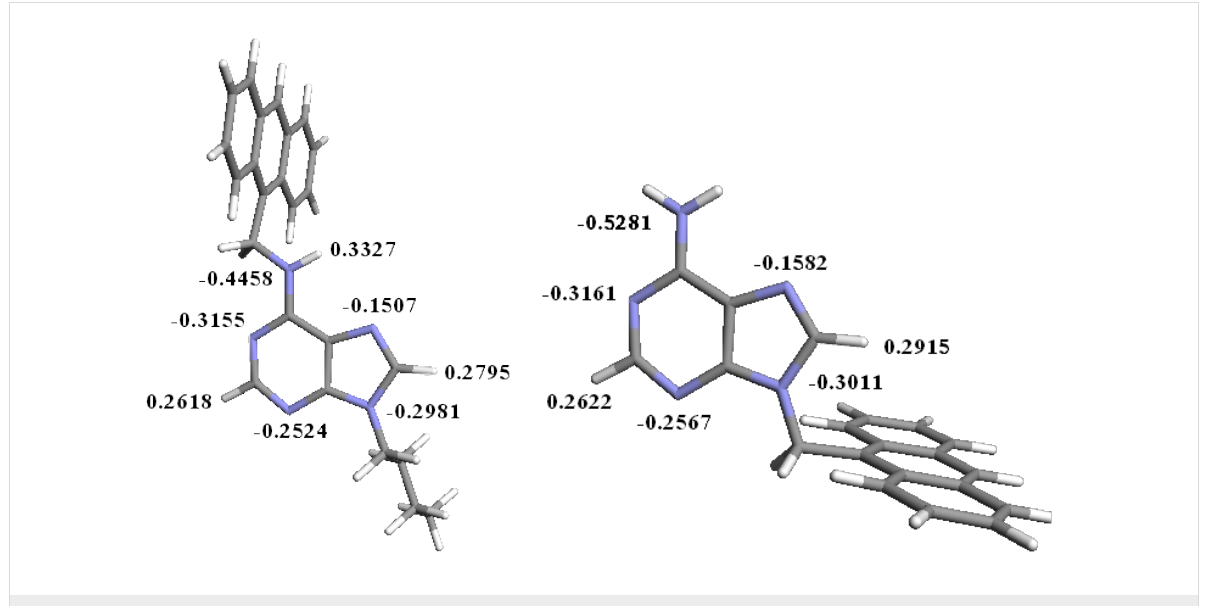
Figure 2: AM1 optimized geometries of 1 (E = − 162.48 au) of 2 (E = − 139.59 au).